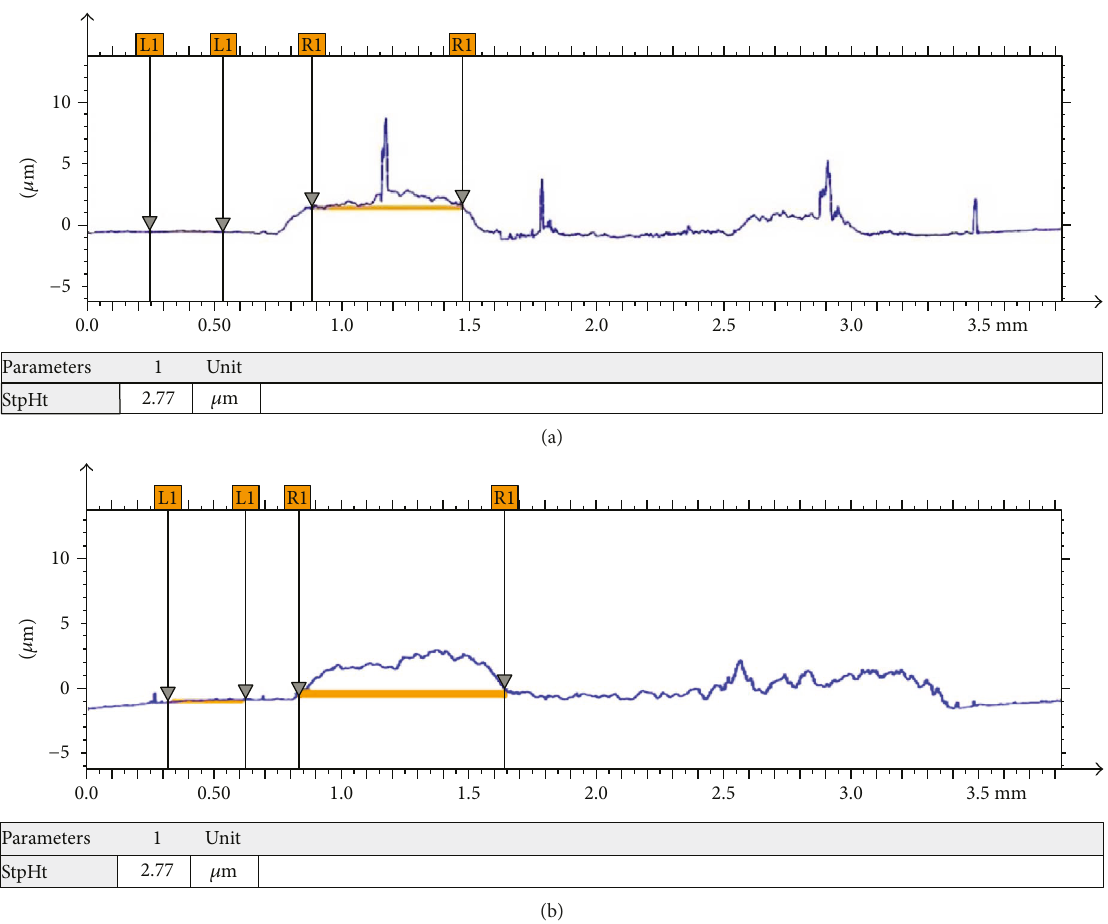
Figure 7: Thickness comparison: (a) before etching and (b) after